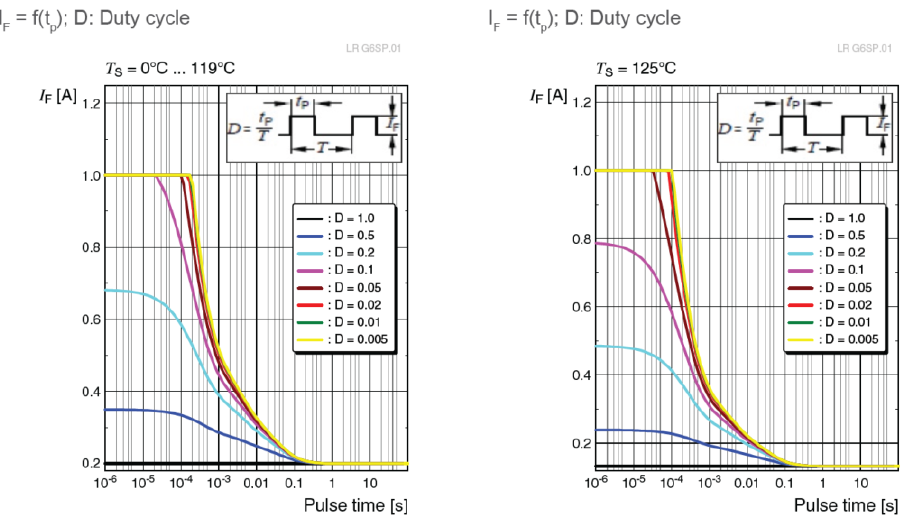
Figure 4. Pulse handling capability of an LR G6SP.01 LED up to 119 °C and for 125 °C [37].